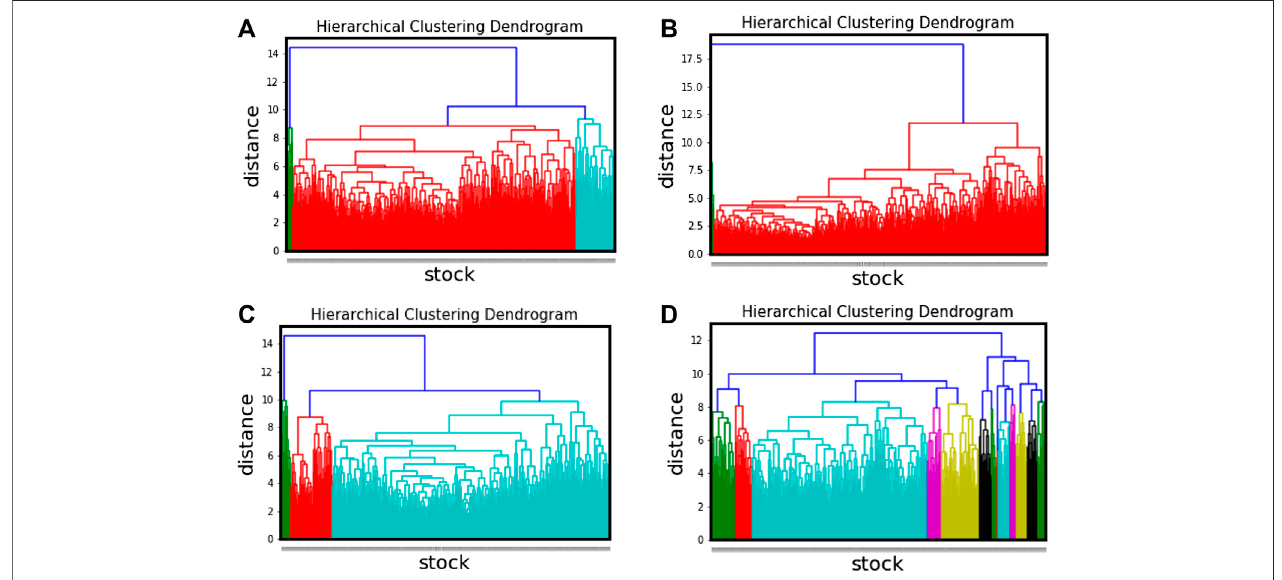
FIGURE15| Thehierarchical clusteringdendrogram forfour periods inTAIEX,i.e. (A) from Jun2018toNov 2018, (B) Sep2018toFeb2019, (C) Oct 2018toMar 2019, and (D) Dec 2018 to May 2019.